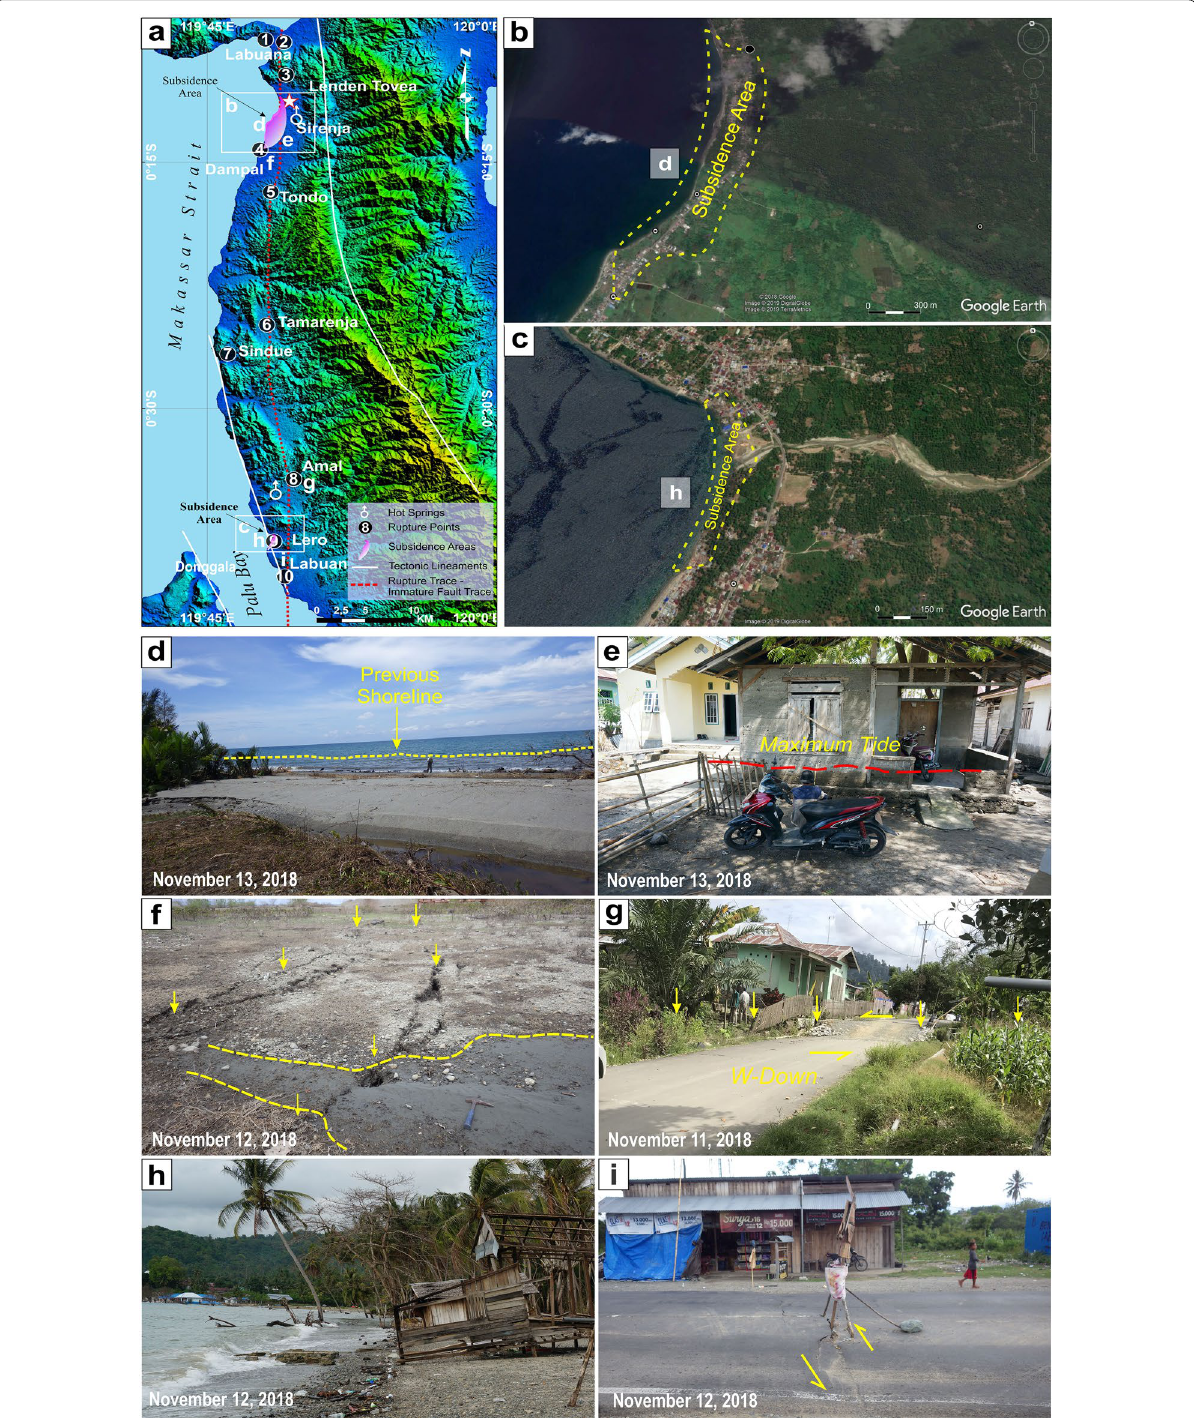
Fig. 3 a Site map of surface rupture, ground fissures, hot springs, and subsidence areas in the Donggala area. Structural lineaments are dawn after Watkinson and Hall (2017). The base map is a 30-m DEM-SRTM (USGS). b The subsidence area around Sirenja coastline (overlaid on Google Satellite imagery, darker updated from 2016 and lighter updated from 2018) and c Lero coastline (overlaid on Google Satellite imagery updated from 2018). d The shoreline retreated landward due to subsidence at Dampal-Lenden Tovea village. e Maximum tide as evidence of subsidence at Dampal-Lenden Tovea village. f Fissures and sand eruption at Dampal village. g A surface rupture cutting a road in Amal village. h The shoreline retreated landward and eroded houses and coastal forests due to subsidence at Lero village. i A displacement across the road at Labuan